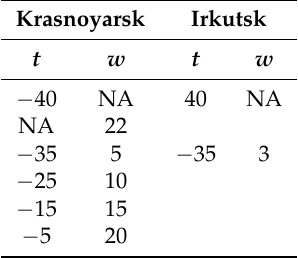
Table 2. Temperature ( t , ◦ C) and wind speed ( w , km/h) thresholds to declare actirovannye dni (non-working days) in Krasnoyarsk Krai and Irkutsk Oblast. Krasnoyarsk